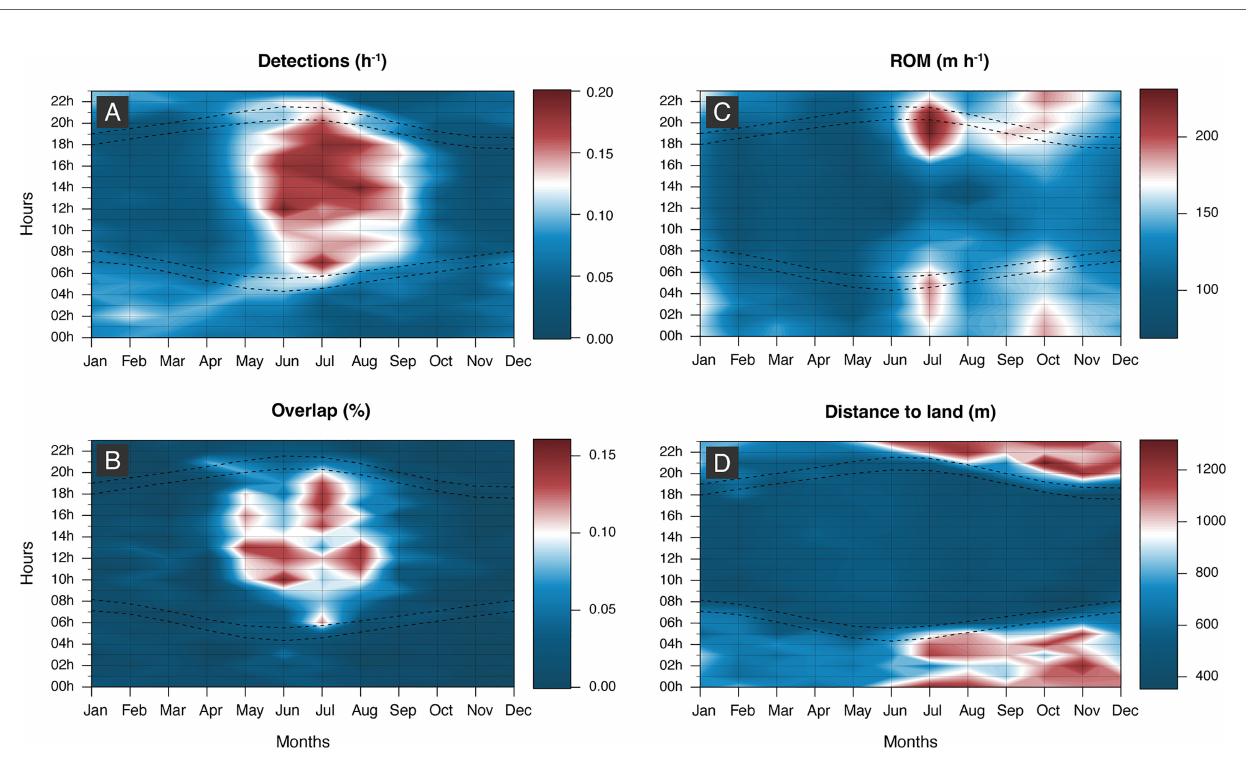
FIGURE 5 | Contour plots representing the overall (A) acoustic detection frequencies, (B) overlap, (C) rate of movement (ROM), and (D) distance to nearest coast averaged per hour and month of nine acoustically tagged smooth hammerhead shark ( Sphyrna zygaena ). Dashed lines mark the times of dawn and dusk estimated for the study site illustrating the annual variation in daylight